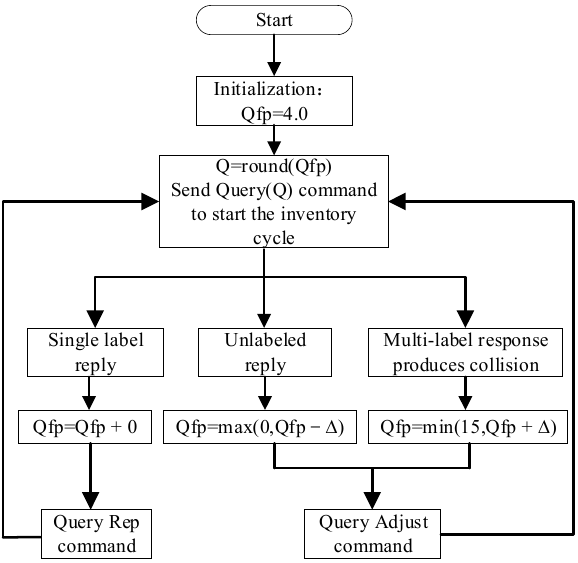
Figure 13. Q algorithm program fl owchart.